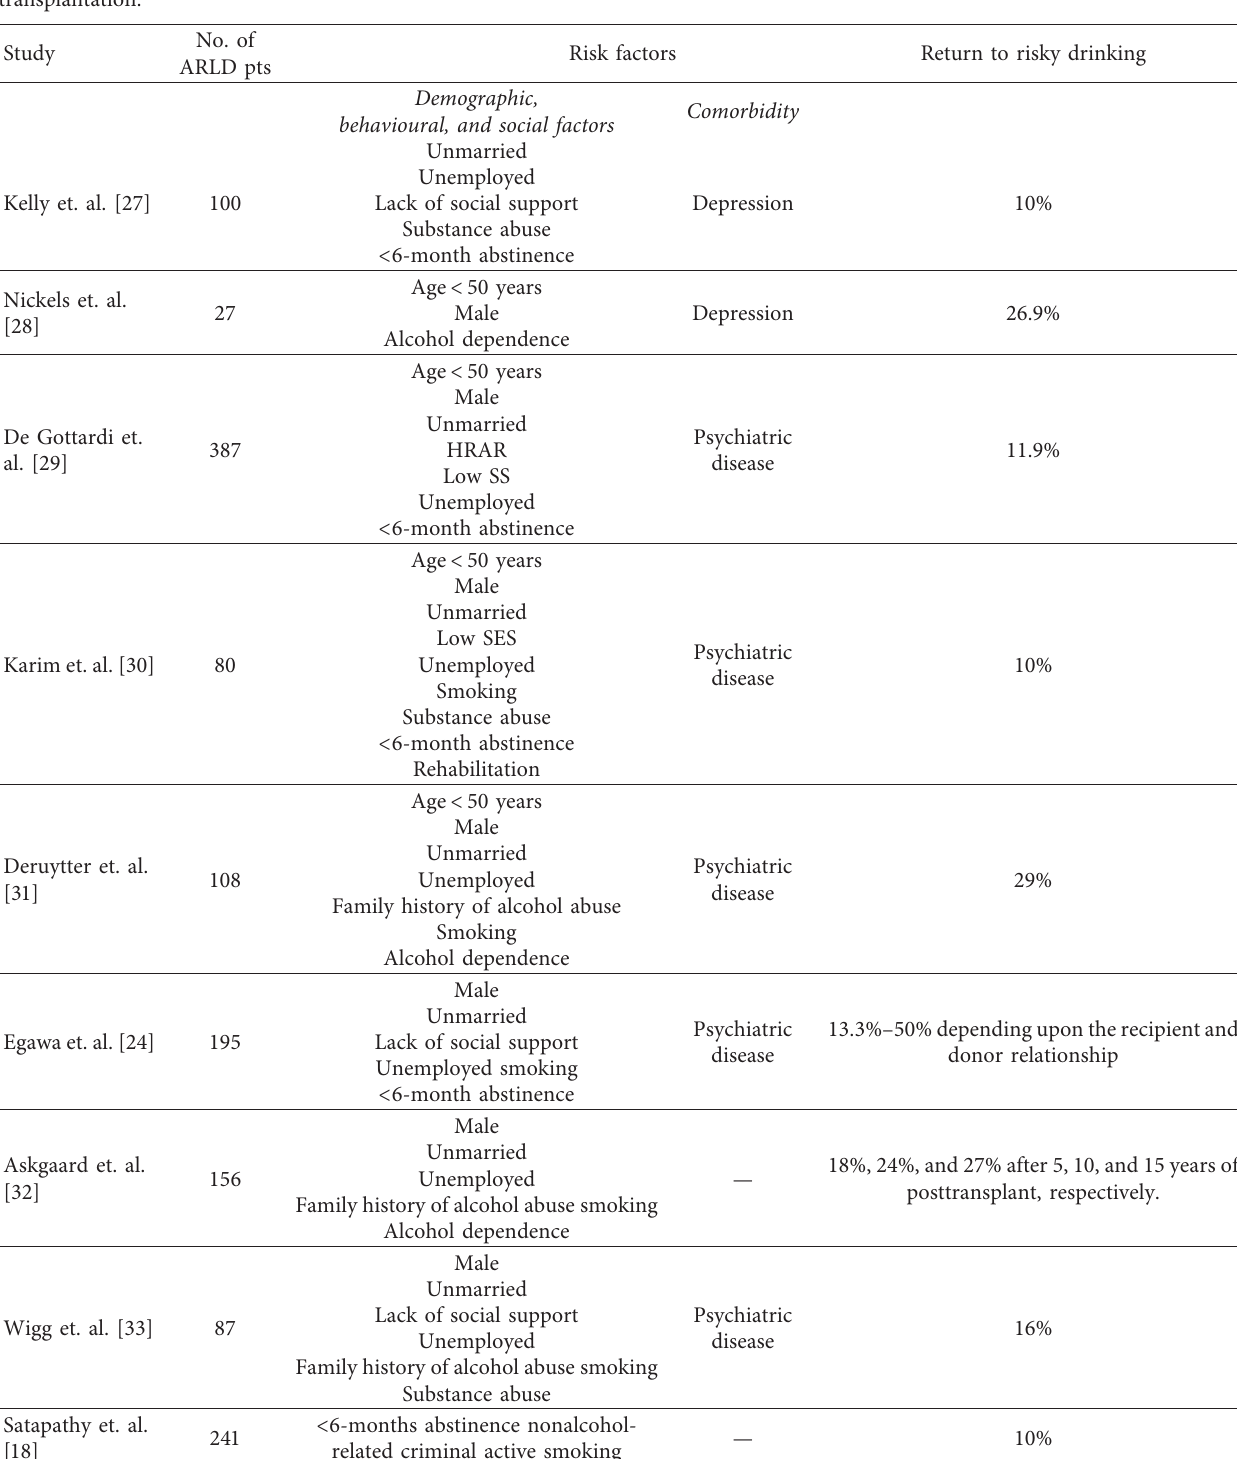
Table 3: Studies comparing risk factors for return to risky drinking for patients with alcohol-related liver disease (ARLD) undergoing liver